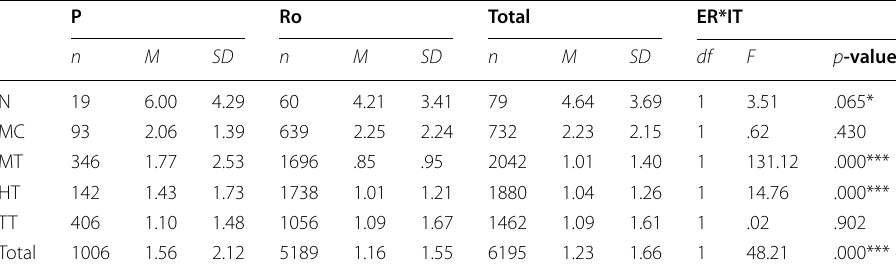
Table 6 Influence tiers, identity type and